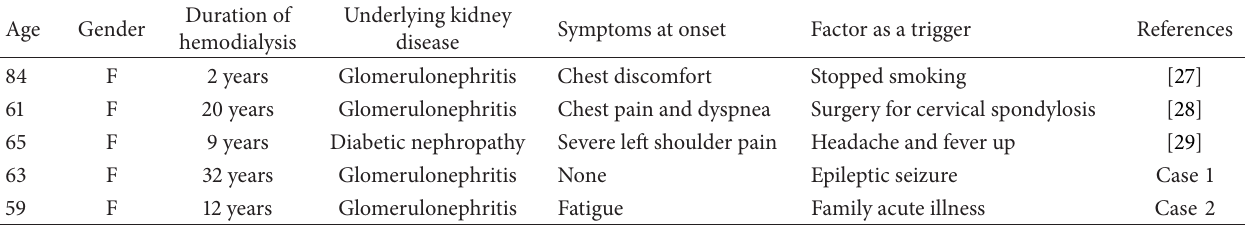
Figure 4: Case 2. ((a), (b)) Echocardiogram on admission demonstrated apical akinesis and ballooning of the left ventricle apex (arrows). (a) End-diastolic phase; (b) end-systolic phase. ((c), (d)) Echocardiogram 3 weeks later showed recovered left ventricular apical wall motion (c) End-diastolic phase; (d) end-systolic phase. Table 1: Reports of takotsubo cardiomyopathy in hemodialysis